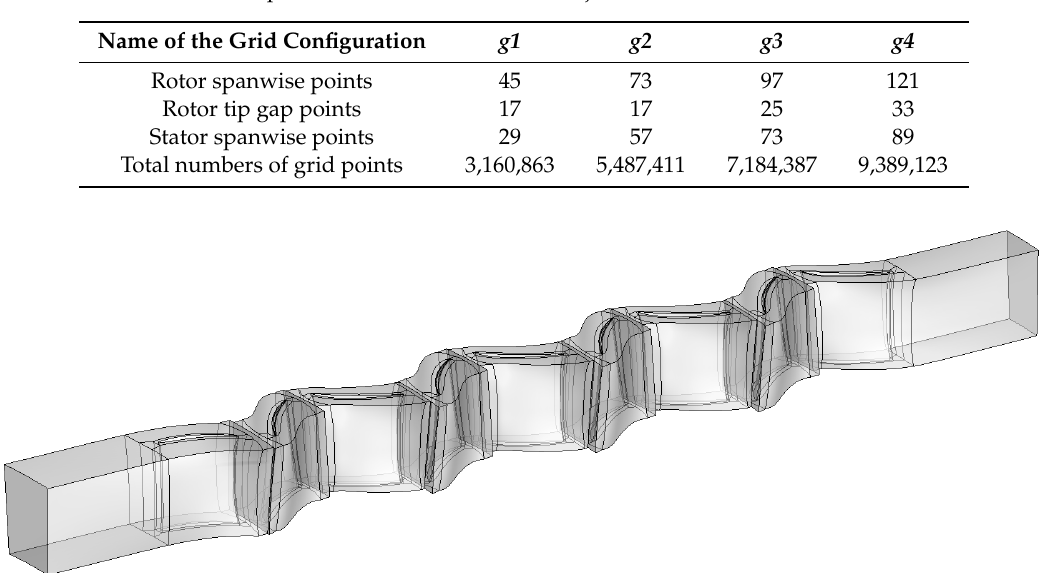
Table 2. Names of optimization schemes for each objective function and the baseline values.